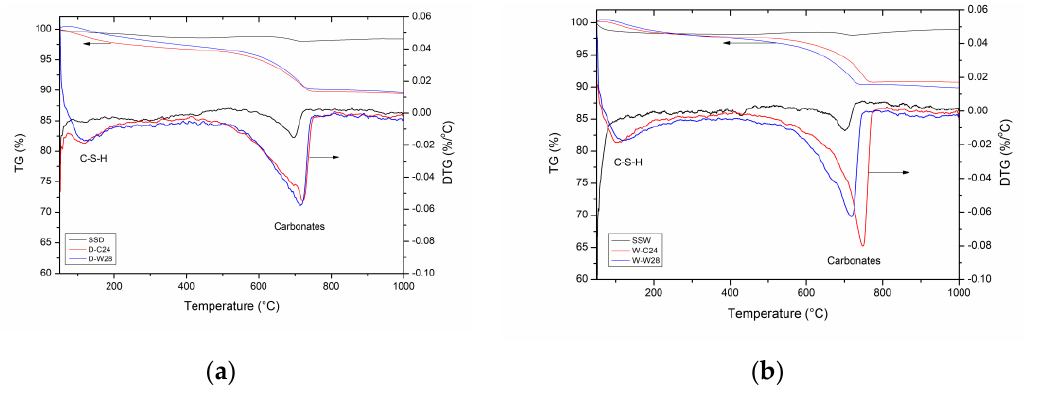
Figure 8. TG-DTA analysis of ( a ) SSD and ( b ) SSW.